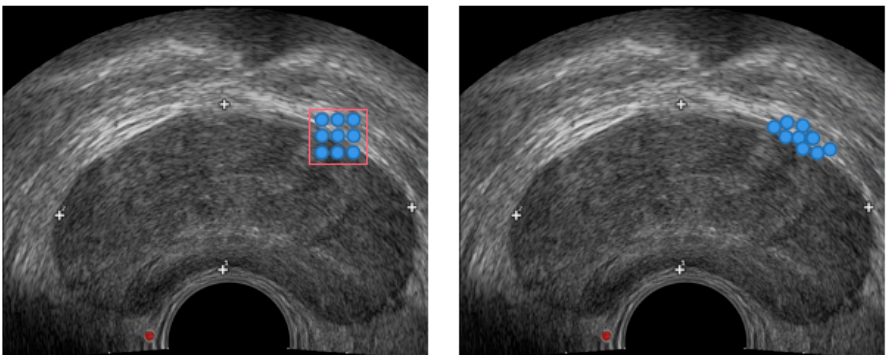
Figure 3. Basic convolution and deformable convolution sampling graph with convolution kernel size 3 × 3.